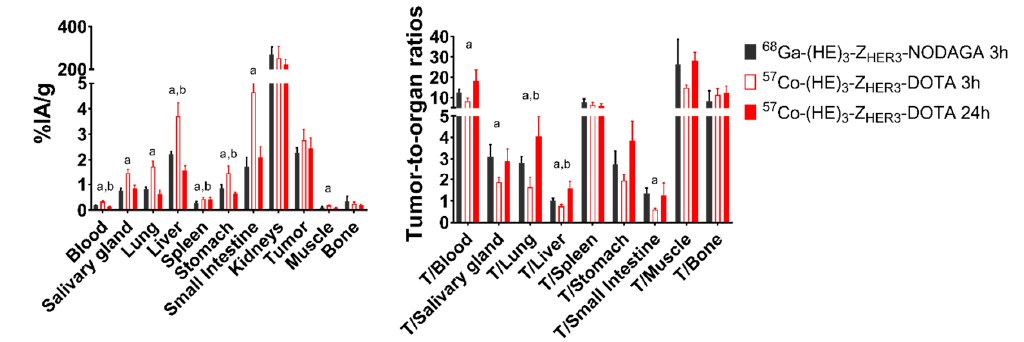
Figure 5. Comparison of the biodistribution of [ 57 Co]Co-(HE) 3 -Z HER3 -DOTA (3 and 24 h pi) and [ 68 Ga]Ga-(HE) 3 -Z HER3 -NODAGA (3 h pi) in BxPC-3 xenografted Balb / c nu / nu mice. Data is presented as the average ± SD of n = 4 animals per